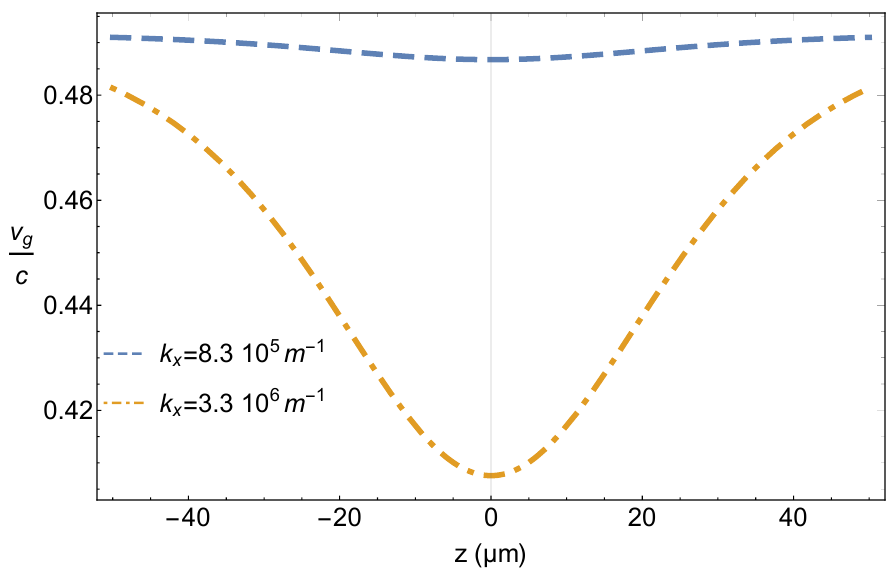
Figure 2. Group velocity v g / c vs the spatial coordinate z for b 0 = 30 µ m, k 0 = 2 π / λ , λ = 780nm, n 0 = 1.5, q = 5.9 · 10 6 m − 1 and the values of k x indicated. The group velocity can significantly decrease near the wormhole throat at z = 0.